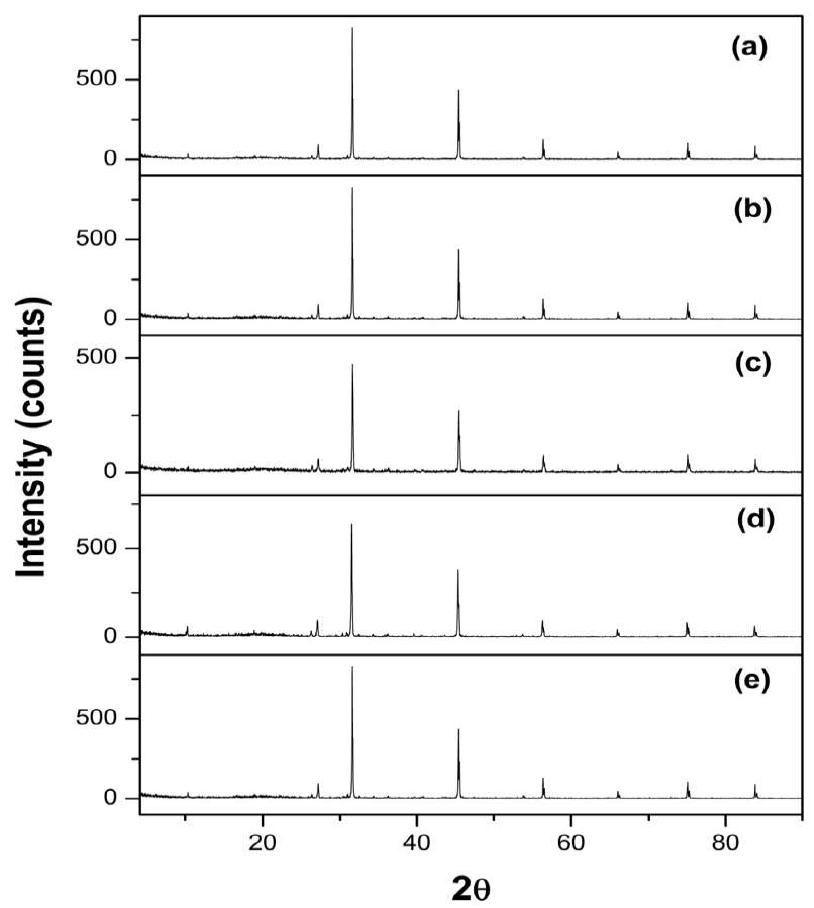
Figure 5. XRPD paerns of ( a ) reference formula, ( b ) F-1-O, ( c ) F-3-O, ( d ) F-4-O, and ( e ) F-5-O.